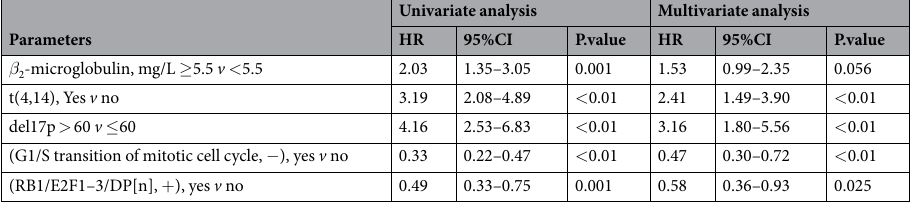
Table 3. Parameters Associated With Overall Survival.